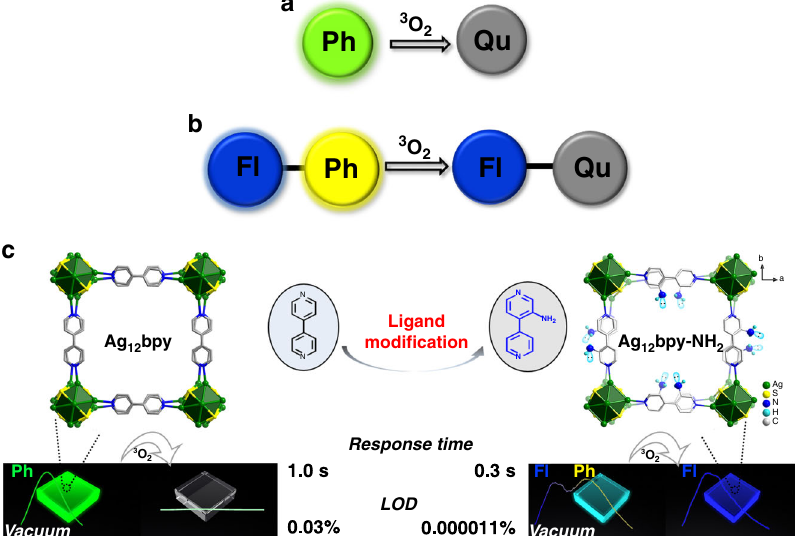
Fig. 1 Schematic luminescent oxygen sensing and ligand modi fi cation of SCC-MOFs. Schematic of oxygen quenching sensing based on a a single Ph emission and b dual Fl-Ph emissions. Fl = Fluorescence, Ph = Phosphorescence, Qu = Quenched. Each colored circle represents an emissive center. c Schematic of Ag 12 bpy crystals emitting a single green color under vacuum that is quenched by oxygen with a response time of approximately 1.0 s and an LOD of 0.03%; the isostructural Ag 12 bpy-NH 2 crystal modi fi ed with − NH 2 groups on the bpy linkers emits nearly a different cyan color that is composed of a blue Fl and a yellow Ph component under a certain vacuum, but only emits blue Fl under oxygen conditions. Note: the color emitted by Ag 12 bpy-NH 2 is variable under different vacuum conditions (see the main text). When using Ag 12 bpy-NH 2 as a ratiometric oxygen sensor, the response time decreased to 0.3 s and the LOD dropped to